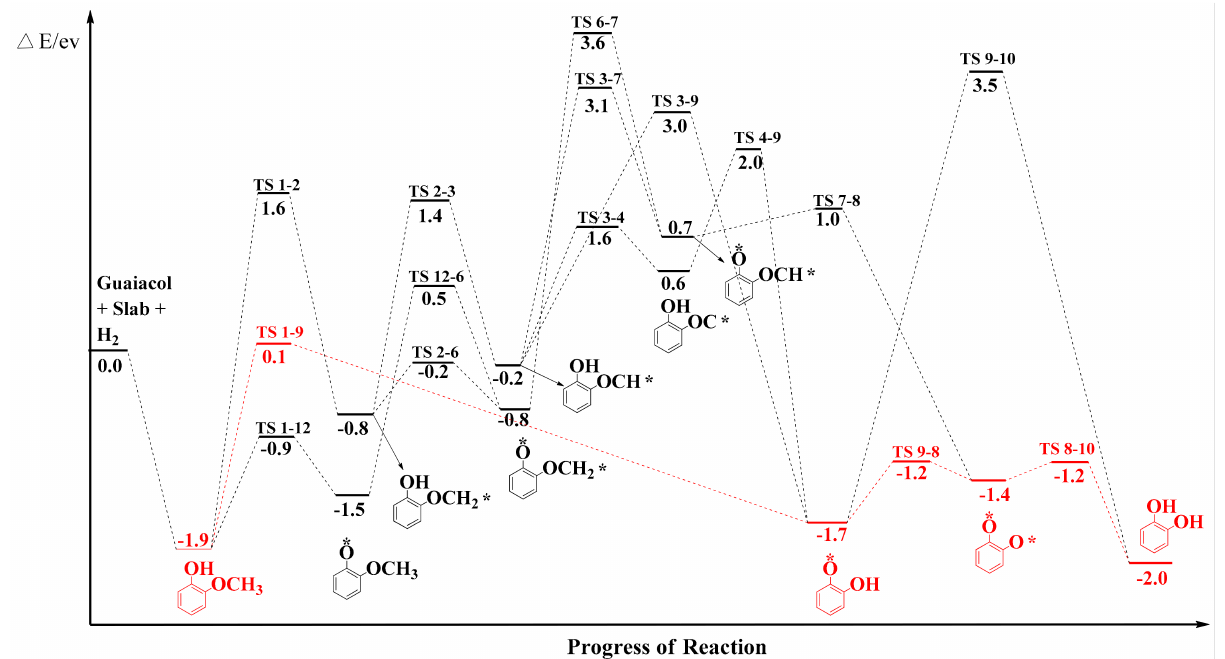
Figure 6. Energy profile diagram for catechol formation. Where the activation energies and reaction energies are reported relative to the isolated reactants i.e., guaiacol, hydrogen gas, and Cu (111) surface. The kinetically accessible pathway is highlighted in red. * indicates on the adsorbate, the sites of decomposition and radical